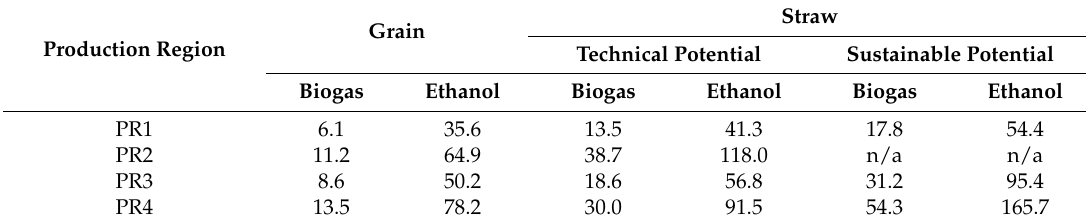
Table A4. Average transport distance [km] for feedstock transportation in the various production regions